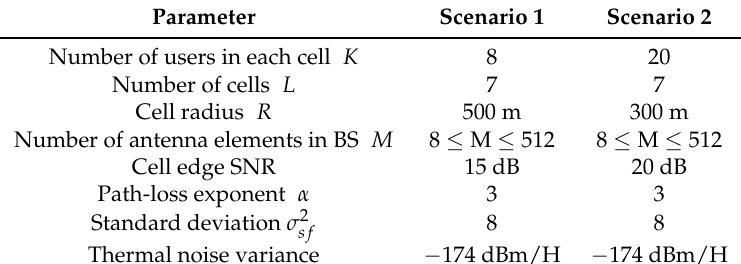
Table 1. The values of the simulation parameters. BS: base station; SNR: signal-to-noise ratio.